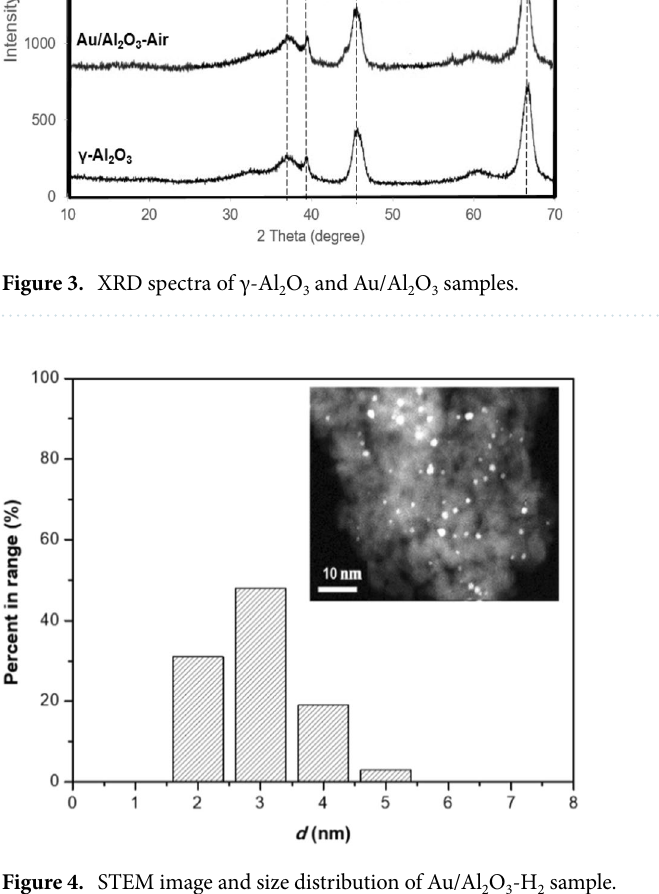
Figure 4. STEM image and size distribution of Au/Al 2 O 3 -H 2